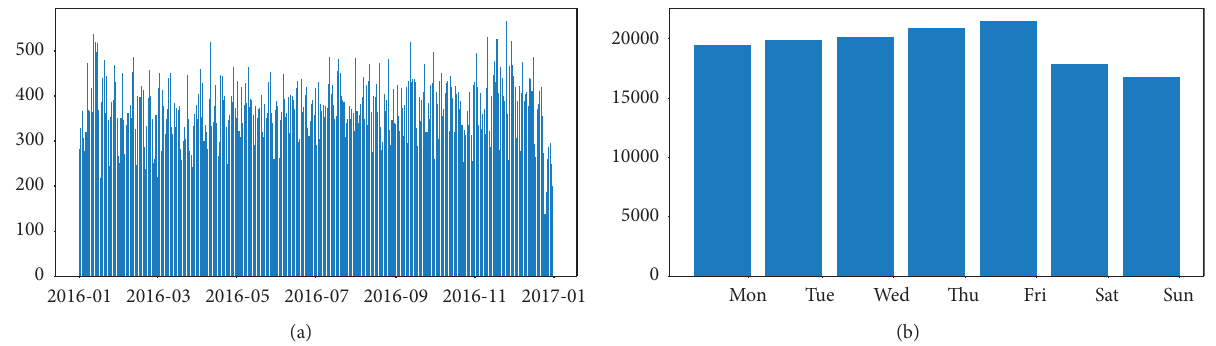
Figure 3: Date dimension and time dimension of the accident bar